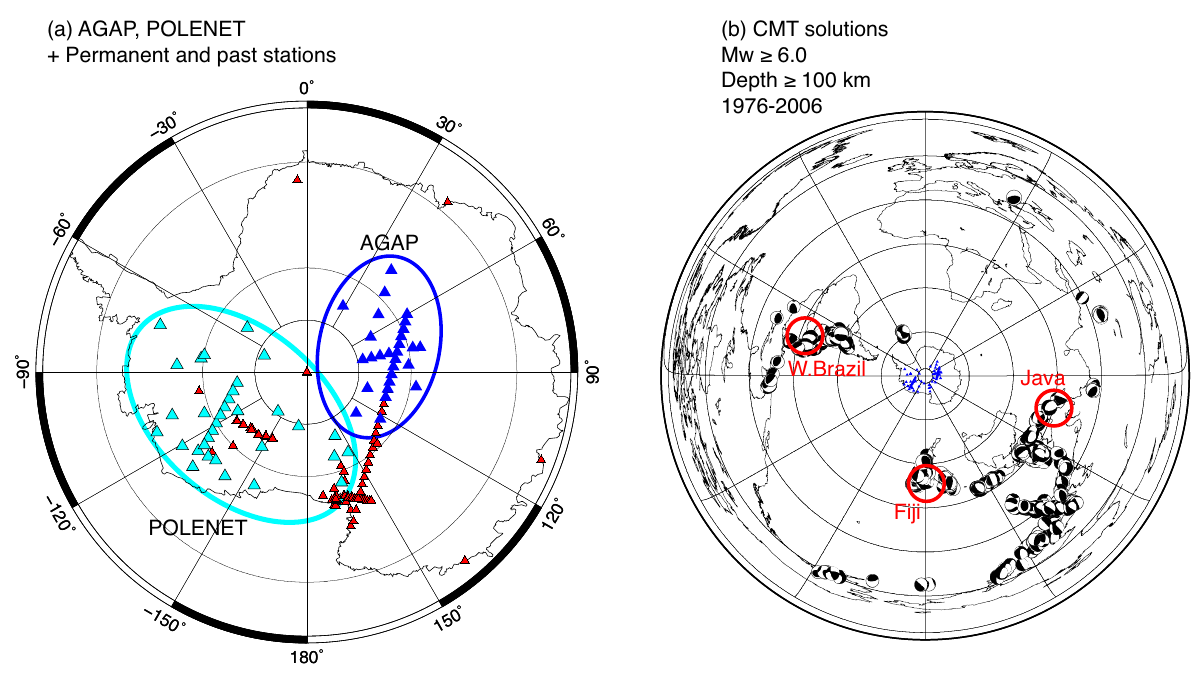
Figure 4. (a) Geographical distribution of the broadband seismic arrays of AGAP (blue triangles) and POLENET (light blue triangles). Stereographic projection is used. Permanent stations and those for the past experiments, such as TAMSEIS are also plotted by red triangles. (b) Geographical distribution of CMT solutions of deep earthquakes (Mw ≥ 6.0, depth ≥ 100 km) in the period of 1976-2006. Equidistant projection is used. The hypocentral areas marked by red circles are discussed here (for Fiji, Java, western Brazil seismic